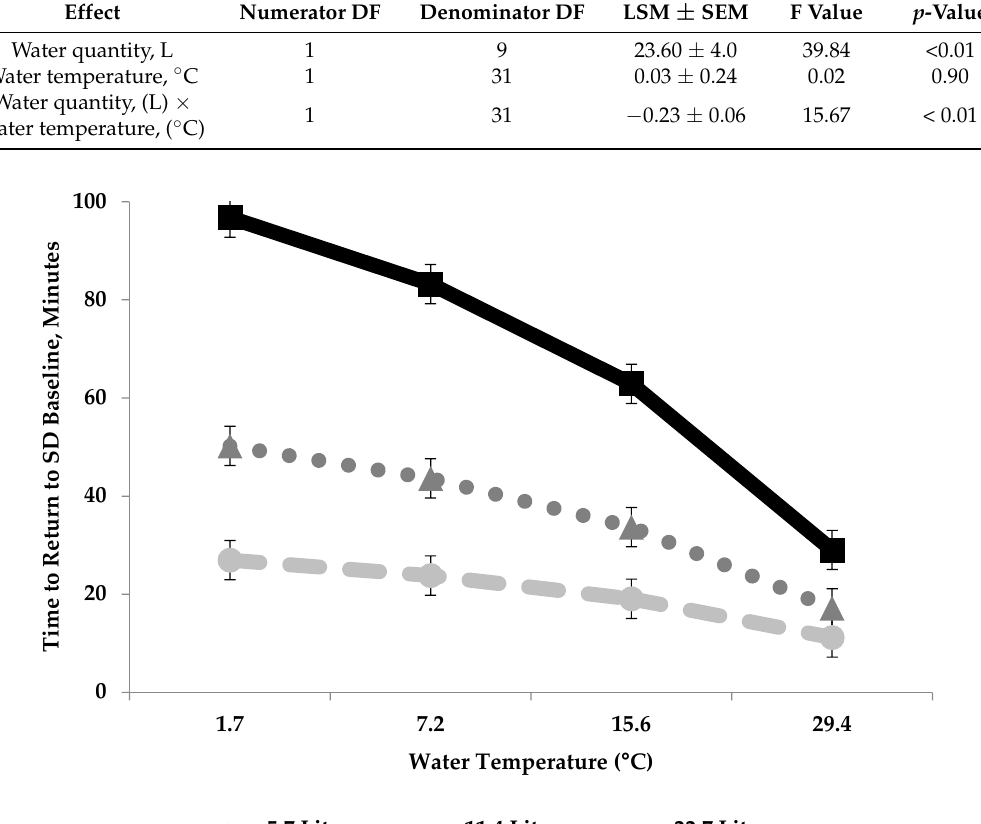
Figure 2. The effect of water quantity (5.7 L, 11.4 L, 22.7 L), water temperature (1.7 °C, 7.2 °C, 15.6 °C and 29.4 °C) and their interaction on the time (min) required to return to baseline reticulorumen temperature (°C) for feed restricted, once daily drenched pregnant cows ( n = 12) explained with the equation: Time to Return to Baseline = 4.33 + (16.06 × Water Quantity (L)) − (0.01 × Water Temperature (°C)) − (0.40 × (Water Quantity (L) × Water Temperature (°C)).